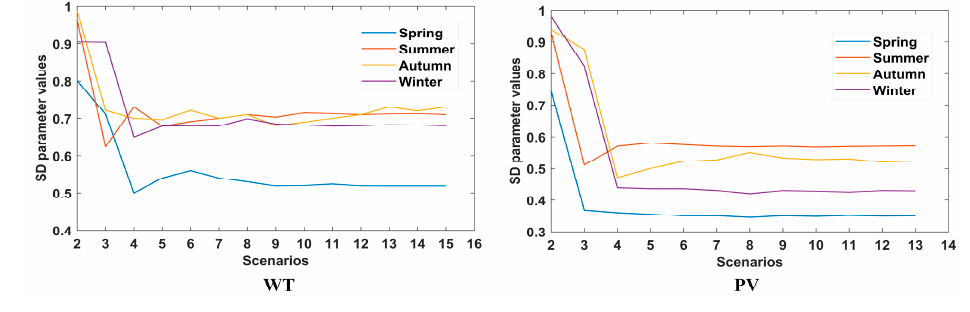
Figure 5. SD index value.